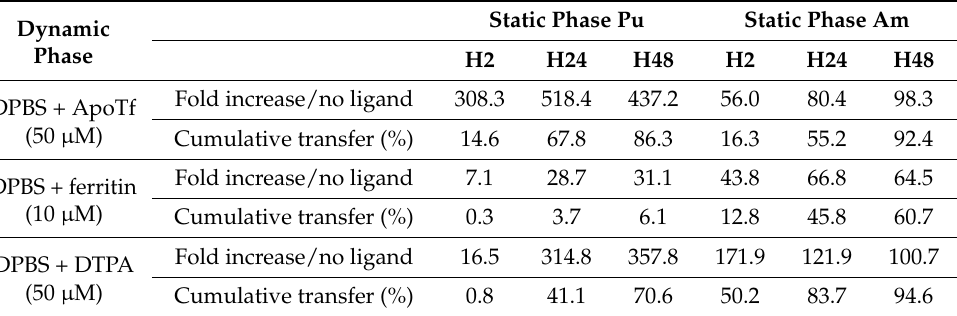
Table 2. Pu/Am transfer enhancement in the presence of proteins or DTPA in the dynamic phase. Ratio of medians of transferred activity in dynamic phase supplemented with ligands vs. control (DPBS alone) and median of cumulative transfer (%). Results are from two experiments performed in triplicate.